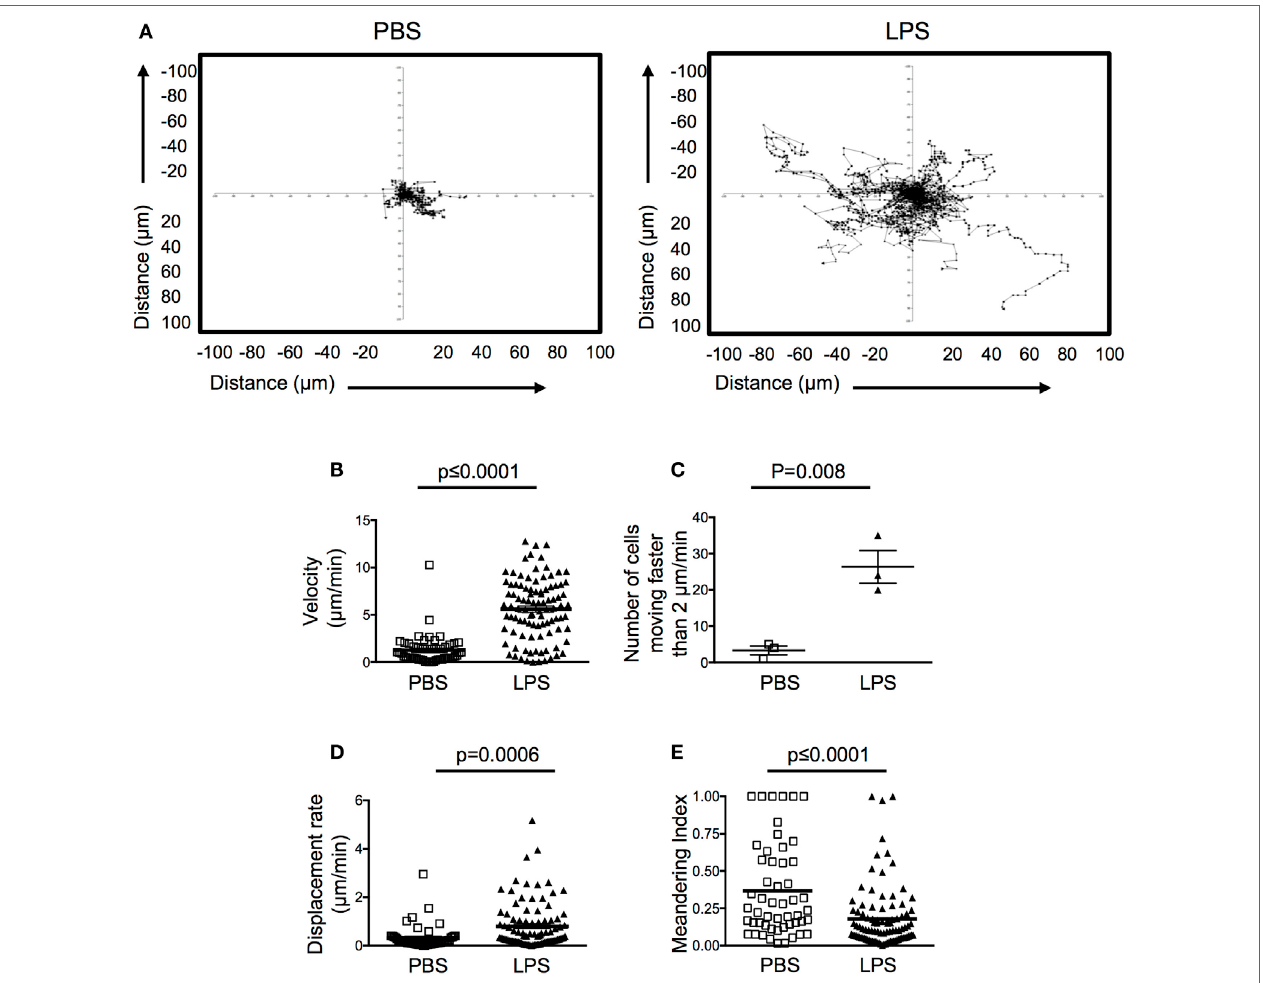
FigUre 3 | Activated CD4 T cells have increased velocity and displacement rate in lipopolysaccharide (LPS)-inflamed sites. Activated OT-II T cells were transferred into the ear pinnae of mice injected with PBS or LPS 24 h previously. After a further 24 h, mice were anesthetized, and OT-II T cells imaged by intravital multiphoton microscopy. Data show tracks of individual cells from the ear of one mouse per treatment (a) or combined data to show velocity (B) , number of cells per mouse moving above 2 μ m/min (c) , displacement rate (D) or meandering index (e) . In panels (B,D,e) , each symbol represents a cell, and the horizontal line indicates the mean of the group, in panel (c) each symbol represents a mouse, and the horizontal line shows the mean of the group; error bars are SEM. Three animals were analyzed per